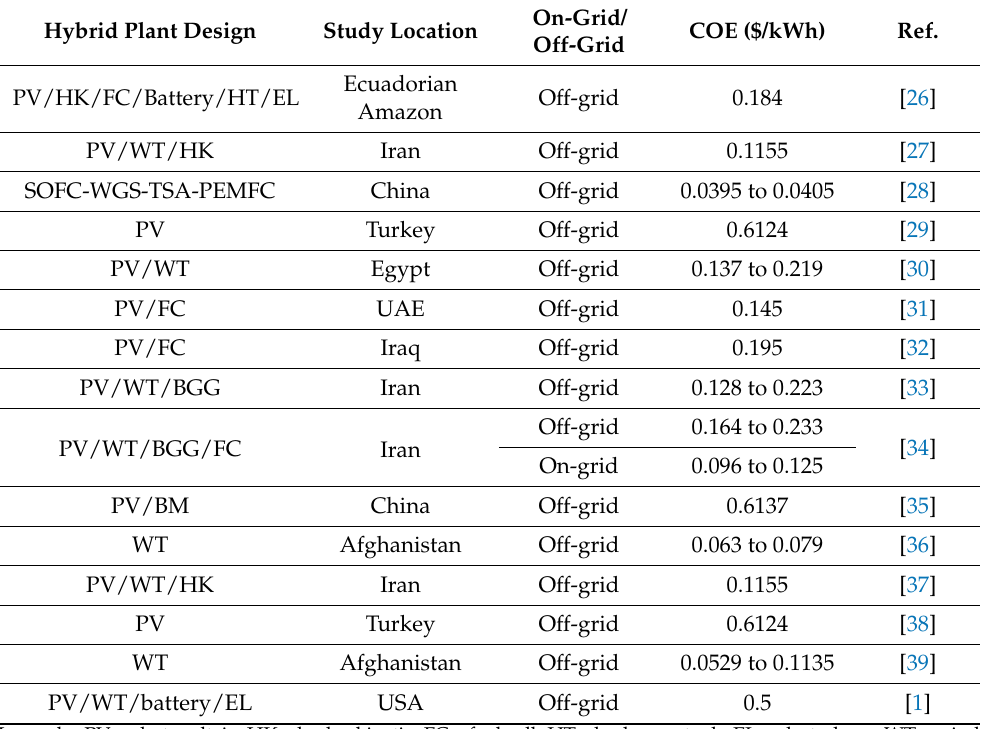
Table 1. Summary of different hybrid energy plants prioritizing hydrogen production. Hybrid Plant